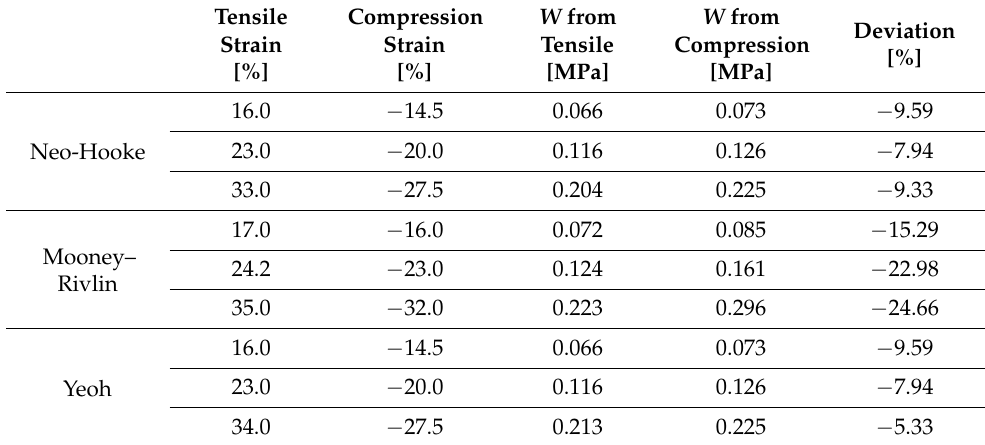
Table 6. Strain energy density function 𝑊 calculated from the raw data for compression and ten- sile tests.